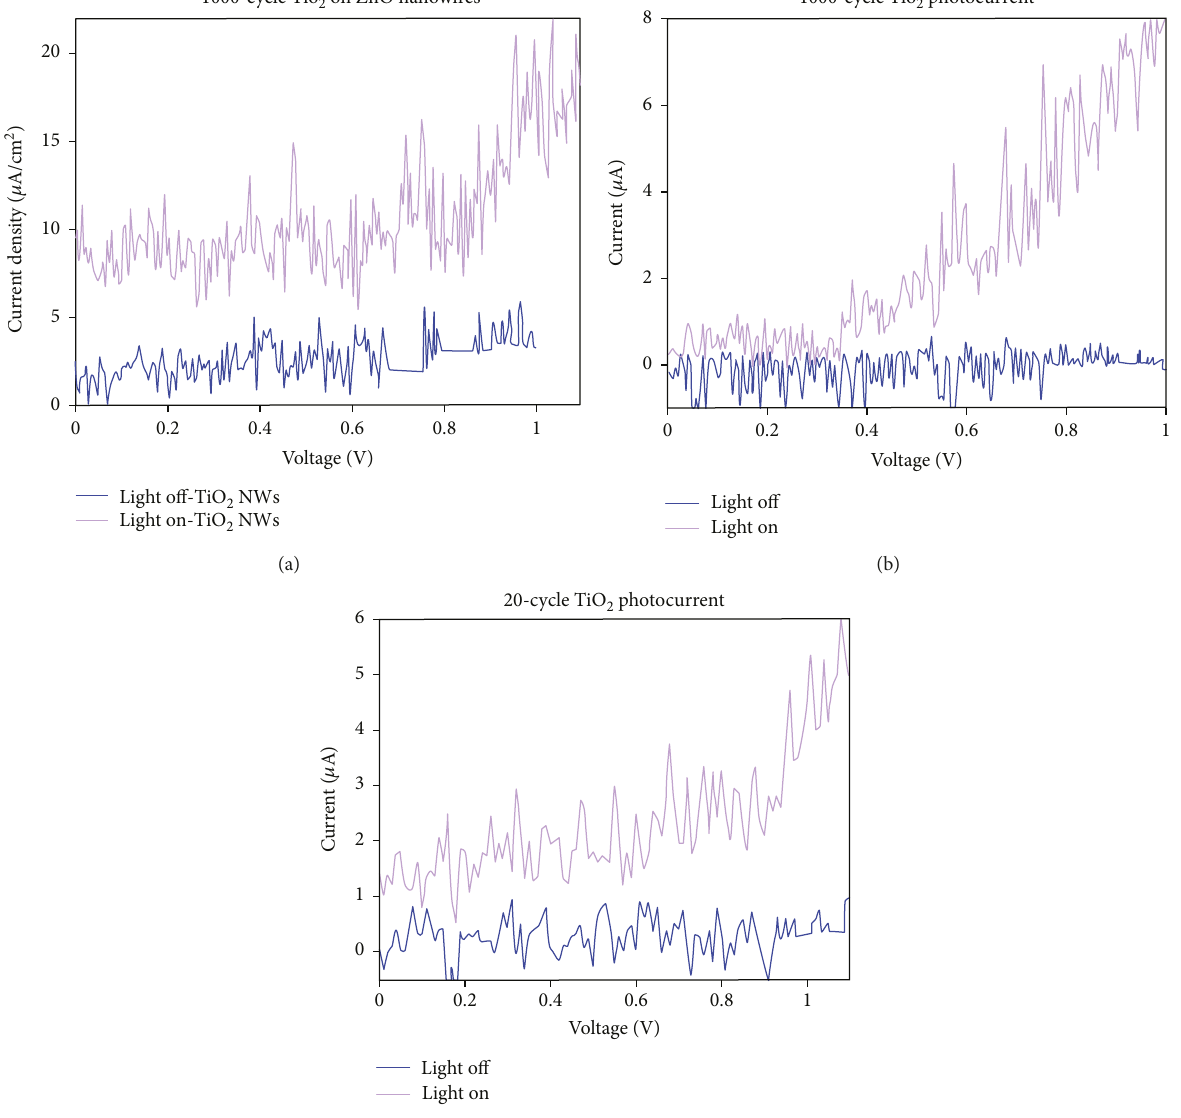
@ZnO show signi fi cantly increased 2 on silicon shows photocurrent 2